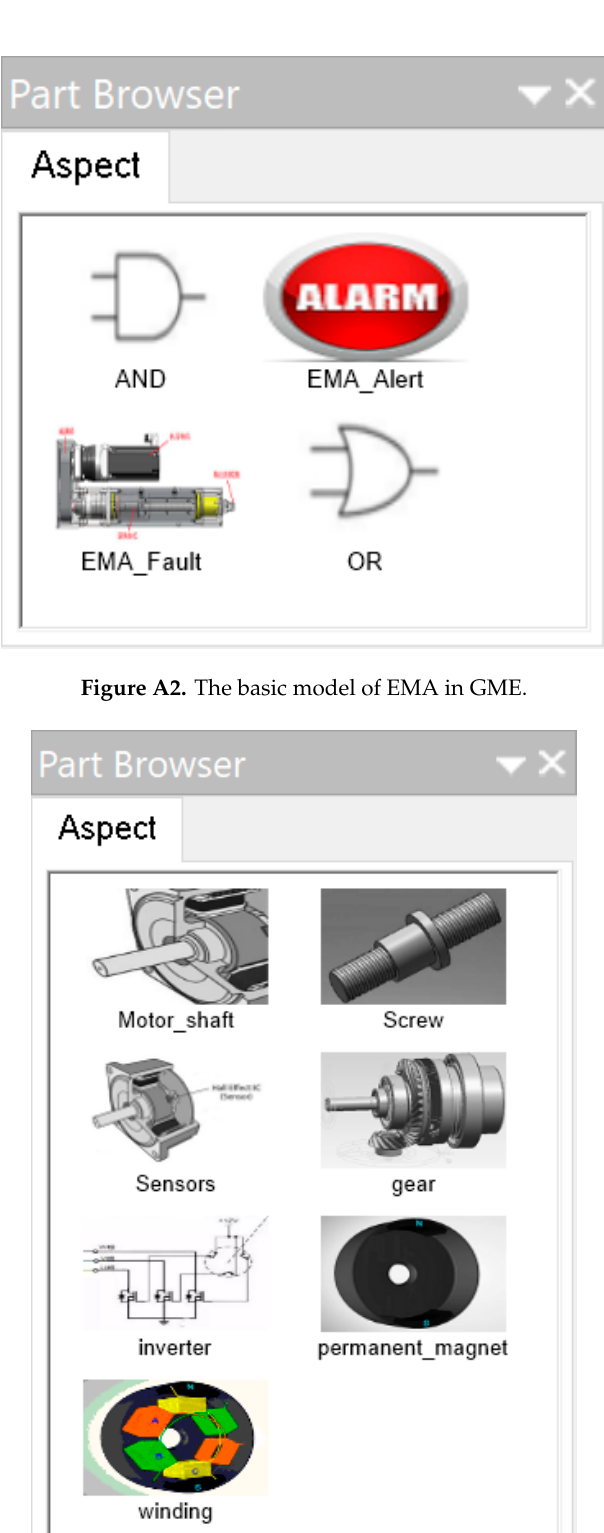
Figure A4. The alarm model of EMA in GME.